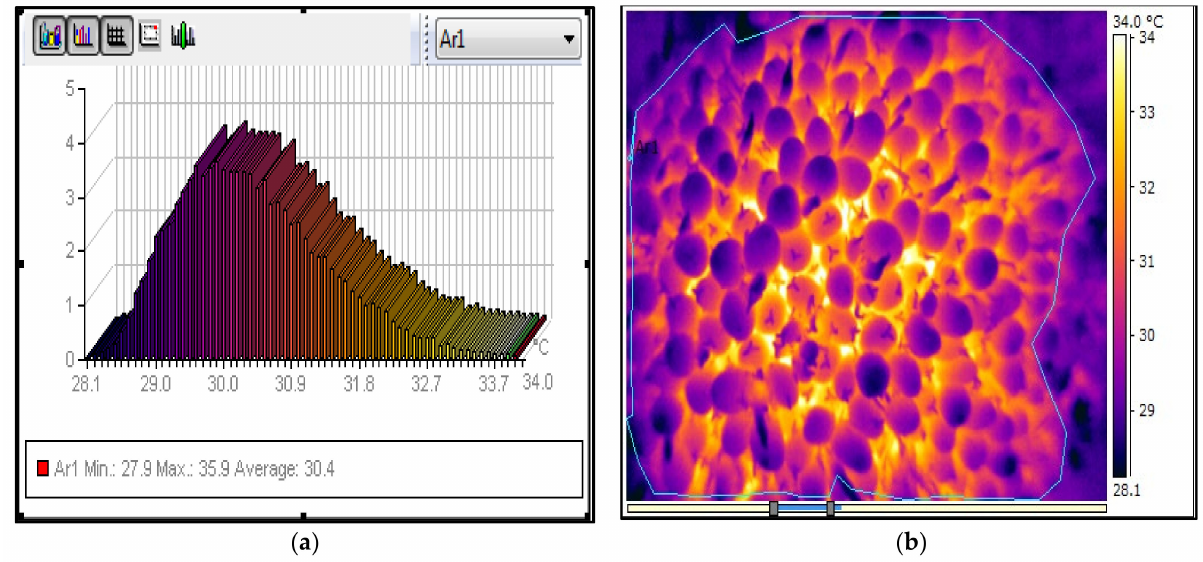
Figure 7. Identifying the ROI: ( a ) histogram of a thermal image after normalization and ( b ) ROI on FFB by digitizing